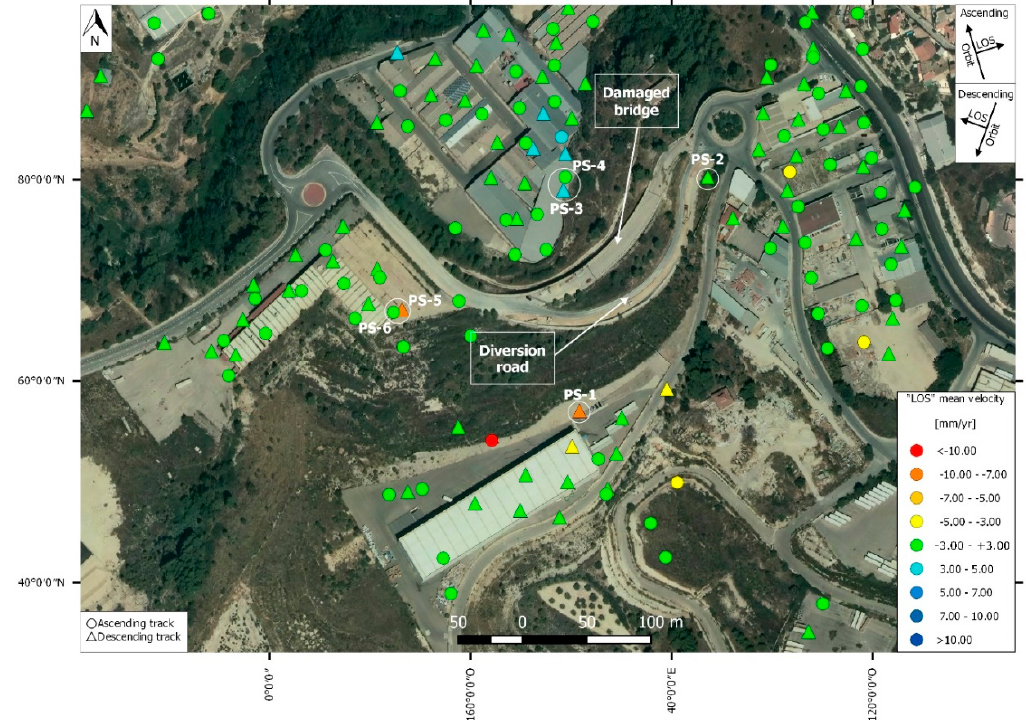
Figure 7. Results of DInSAR analysis. Mean displacement velocity recorded by ascending (circle) and descending (triangle) tracks.